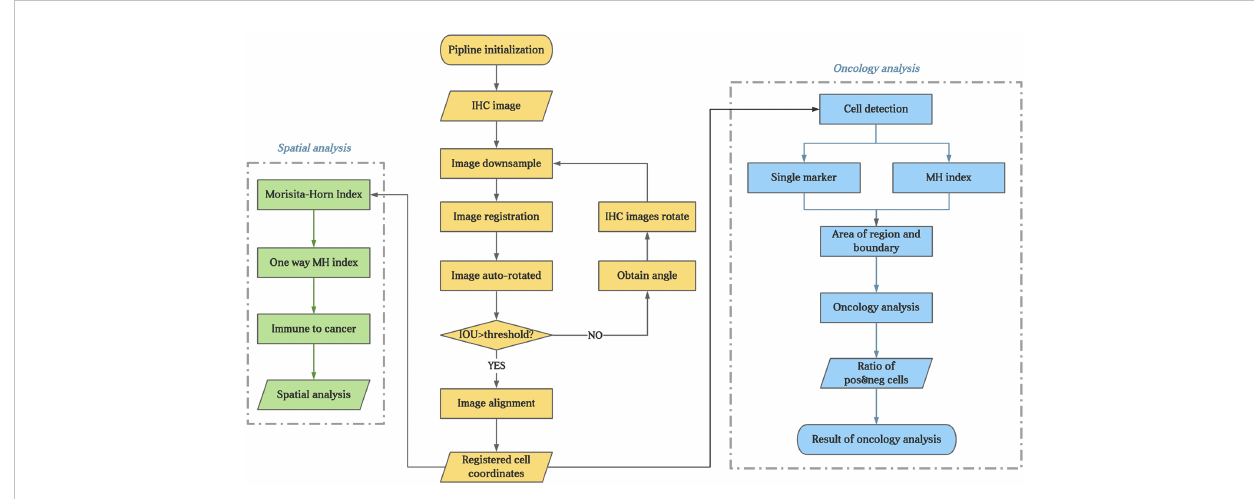
FIGURE 2 The fl owchart of the experiment. The brown part present image registration and annotation process; The blue part present the analysis process of every IHC markers; The green part present process of colocalization of immune marker of tumor